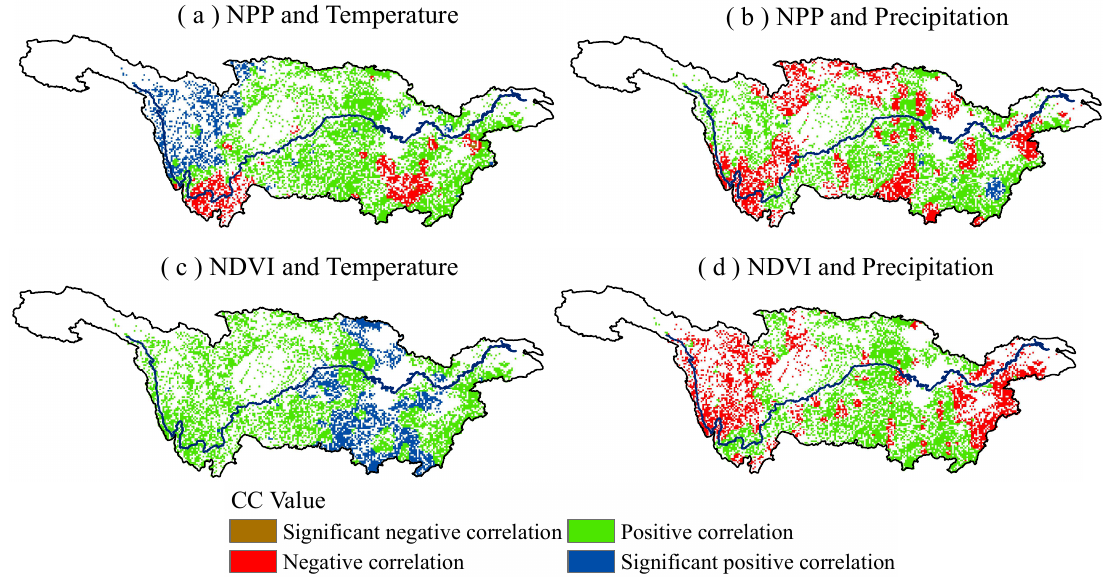
Figure 7. Spatial patterns of the correlation among the accumulated forest NPP and NDVI with climate factors in the Yangtze River basin during the period 1982–2013.